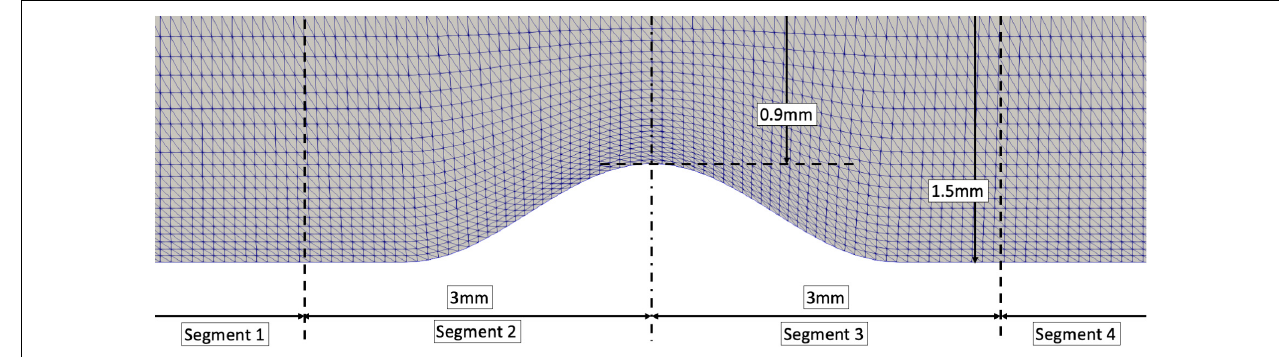
FIGURE 2 | An idealized stenotic model with an artery’s diameter of 3mm and 40% DS. Segment 1: at least 1 diameter from the proximal stenotic segment; Segment 2: 1 diameter from the proximal shoulder of the stenosis to minimal lumen diameter; Segment 3: minimal lumen diameter to 1 diameter distal to the stenosis shoulder; Segment 4: remaining distal